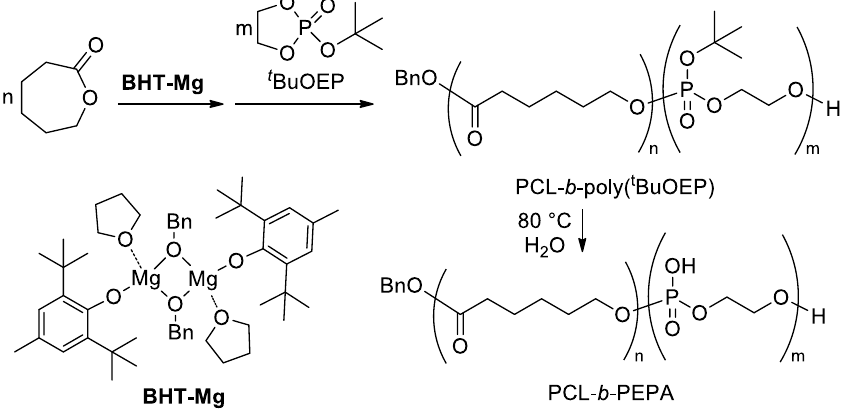
Figure 1. The synthesis of PCL- b -PEPA [36].